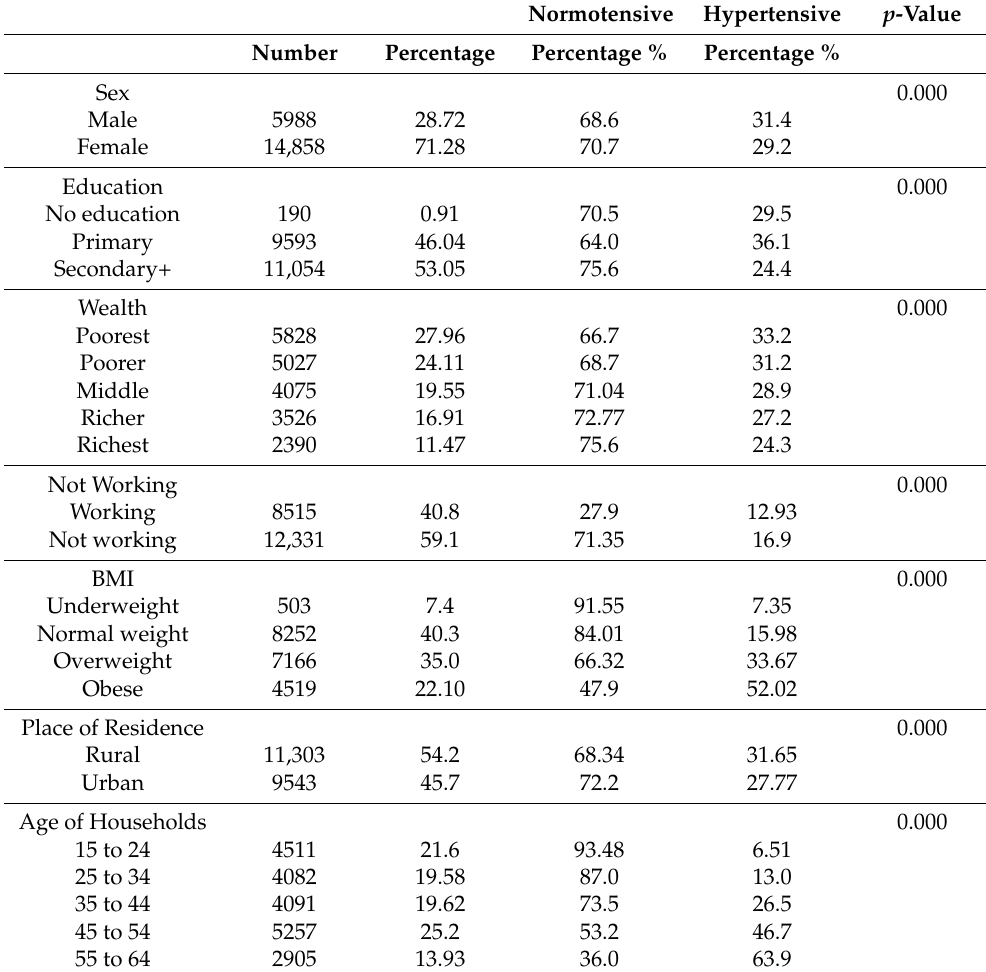
Table 1. Summary of Sample Characteristics of Survey Data in